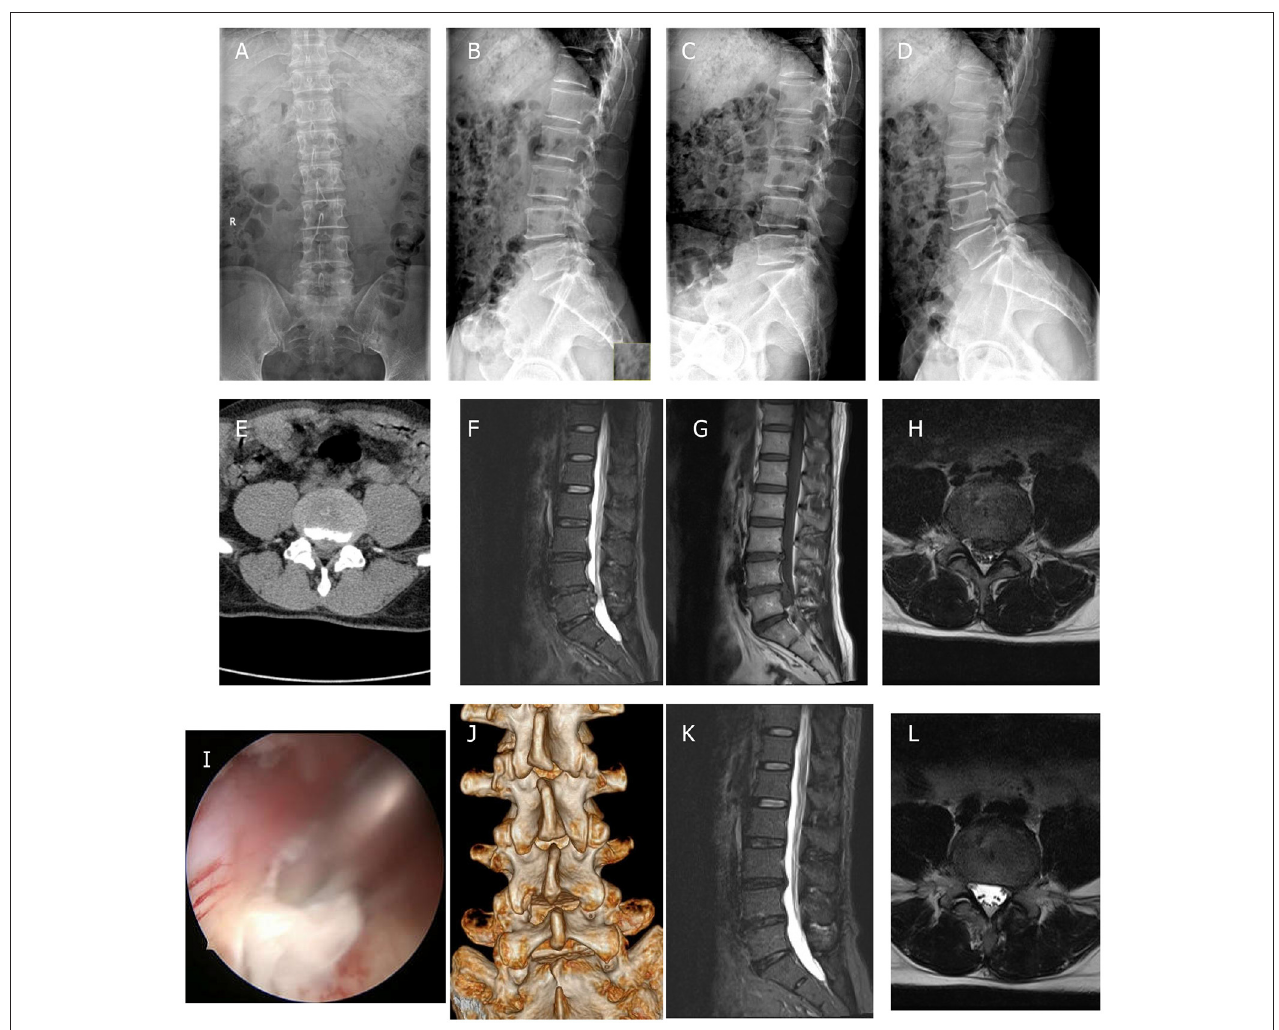
FIGURE 1 | Unilateral biportal endoscopic (UBE) diskectomy was performed on a 47-year-old male patient with L4/5 lumbar disc herniation. (A,B) Preoperative anteroposterior and lateral plain radiographs; (C,D) preoperative flexion and extension radiographs; (E) preoperative CT scans; (F–H) preoperative MRI scans; (I) diskectomy was performed to ensure adequate decompression of the nerve tissue; (J) postoperative 3D-CT scans; and (K,L) postoperative MRI